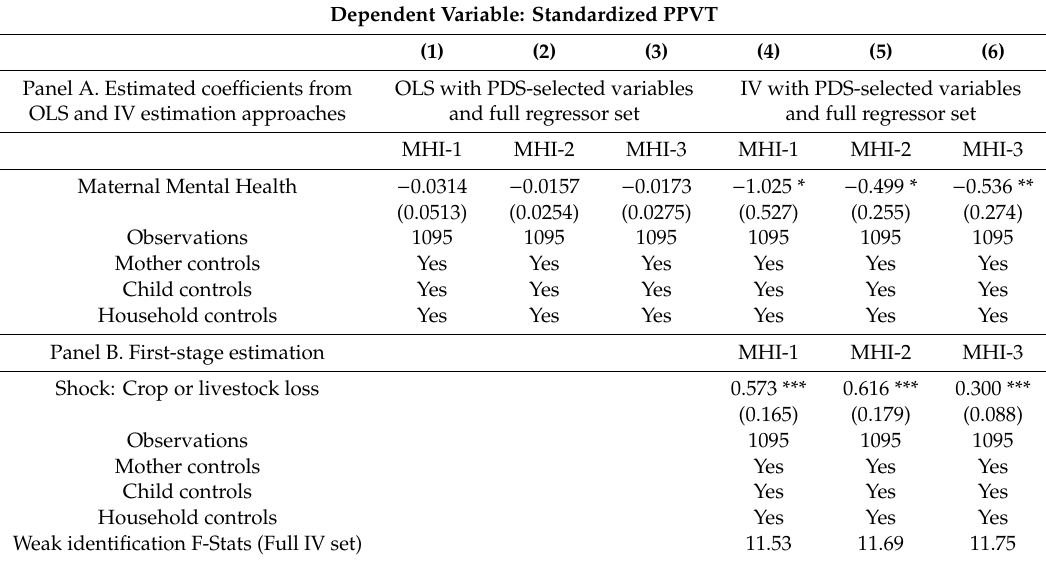
Table 3. E ff ect of maternal mental health on children’s vocabulary at age